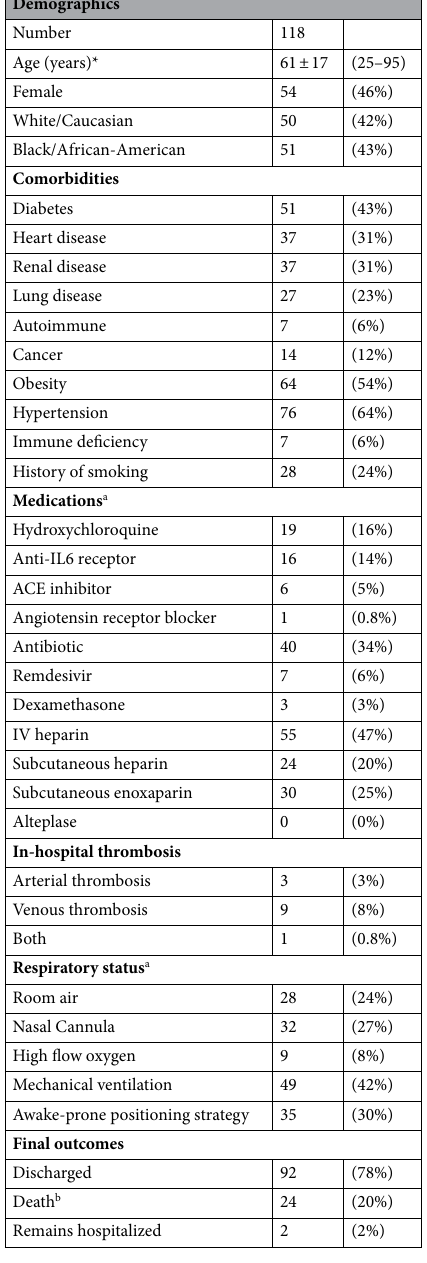
Table 1. Demographic and clinical characteristics of COVID-19 patients. *Mean ± standard deviation (range). a At time of sample collection. b 22 patients died as a result of acute respiratory distress syndrome from COVID- 19, 1 died as a result of septic shock from a superinfection, and 1 died of necrotizing